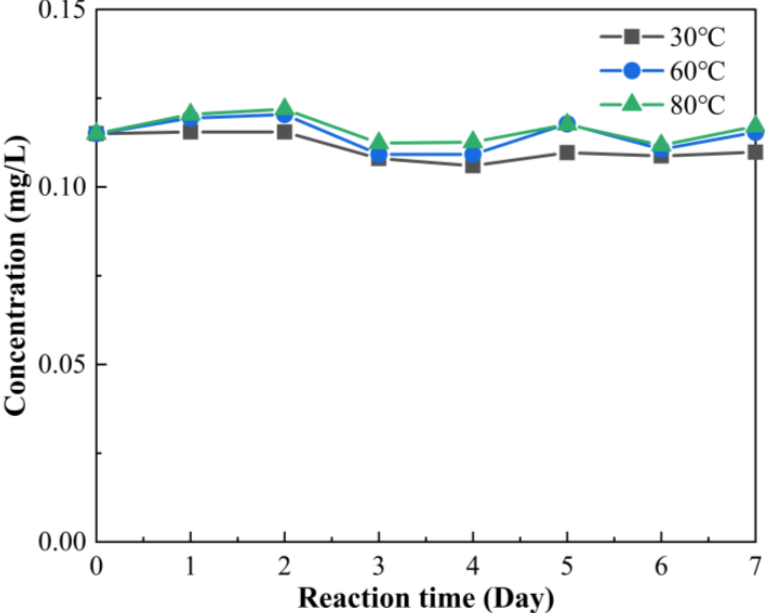
Figure 8. Changes in concentration of CQD-W after aging at different temperatures over a period of time.